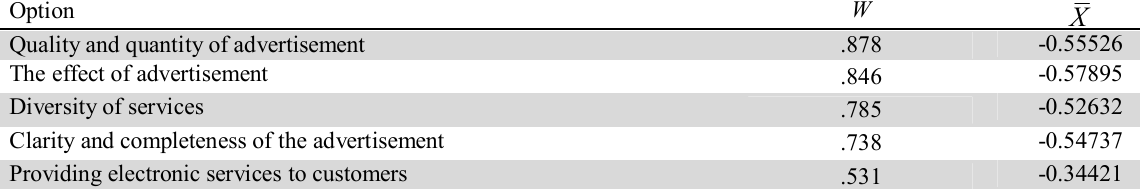
The summary of factors associated with sales improvement and advertisement Option W X Quality and quantity of advertisement .878 The effect of advertisement Diversity of services Clarity and completeness of the